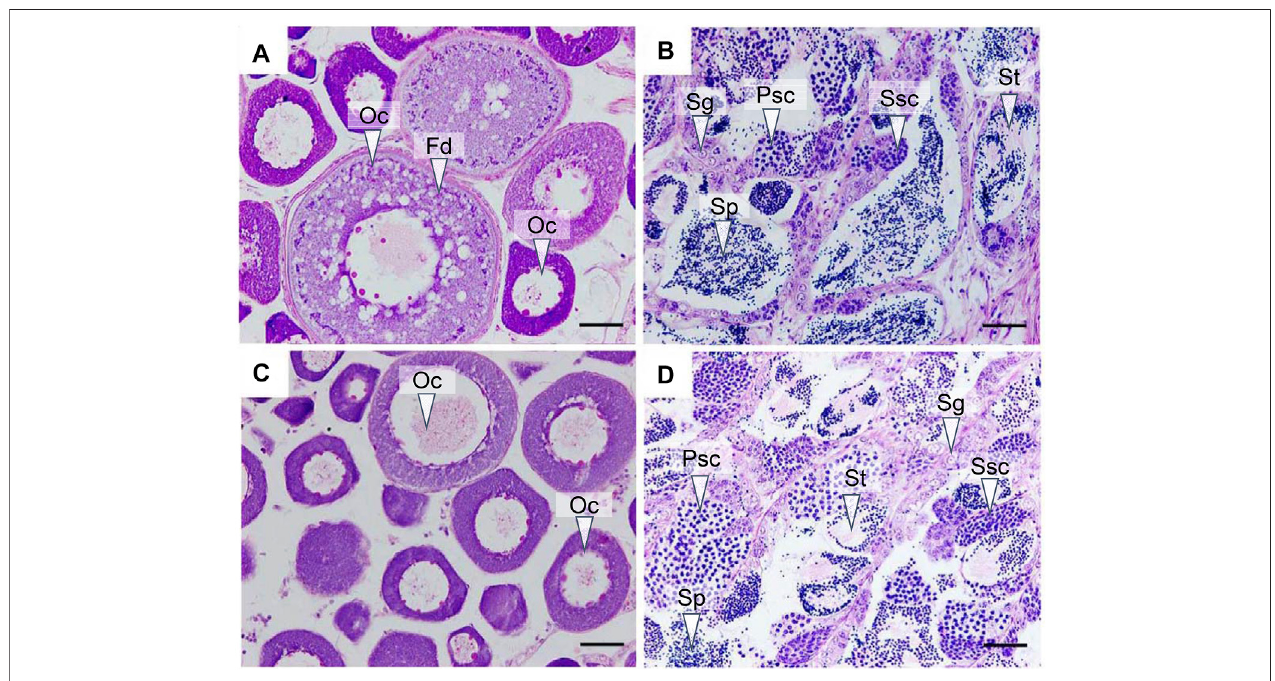
FIGURE1| Histologicalobservationofthegonadsat180 daysposthatch(dph). (A) Ovaryfromthecontrolgroup; (B) testisfromthecontrolgroup; (C) ovaryfrom the gynogenesis group; and (D) testis from the neo-male group. Oc: oocyte; Fd: fat droplet; Sg: spermatogonia; Psc: primary spermatocyte; Ssc: secondary spermatocyte; St: spermatid; Sp: Sperm. Scale bars = 50 μ M.